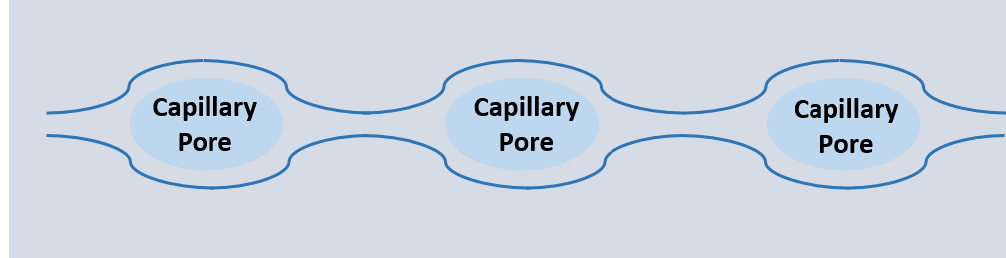
Figure 1. Schematic of capillary pores 𝜑 , lined with C-S-H [62].